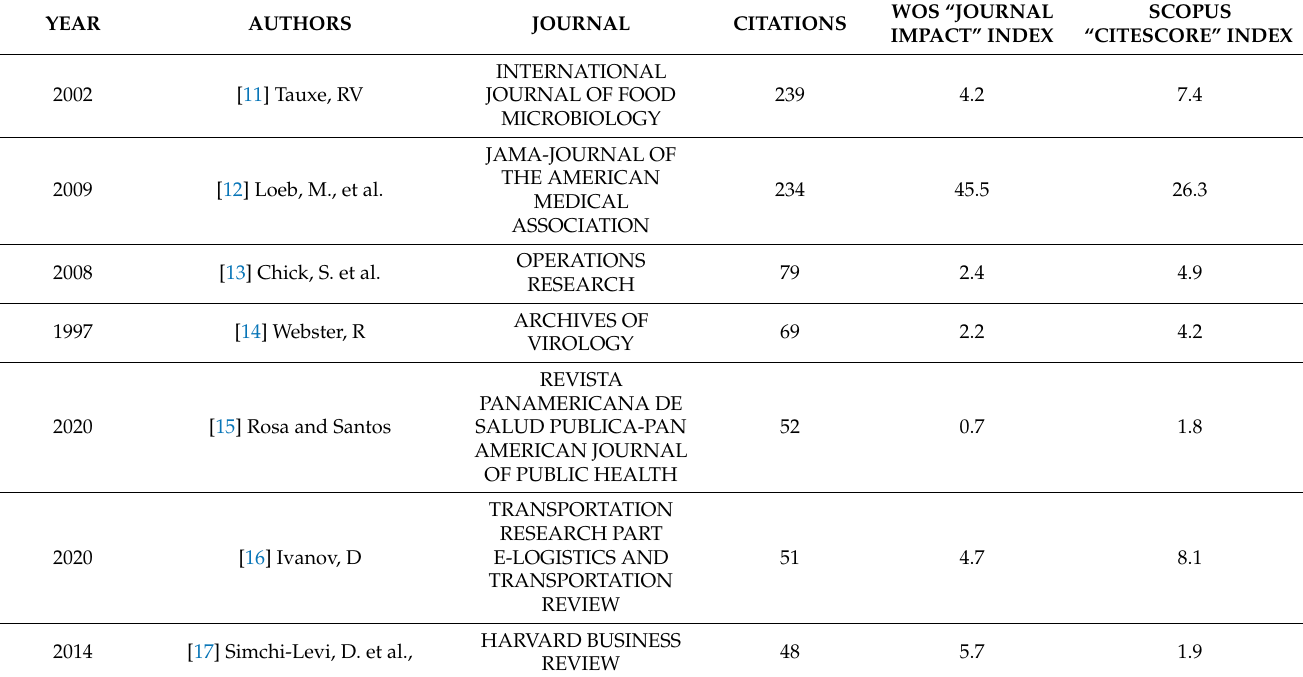
Table 1. Highly Cited Pandemic Supply Chain